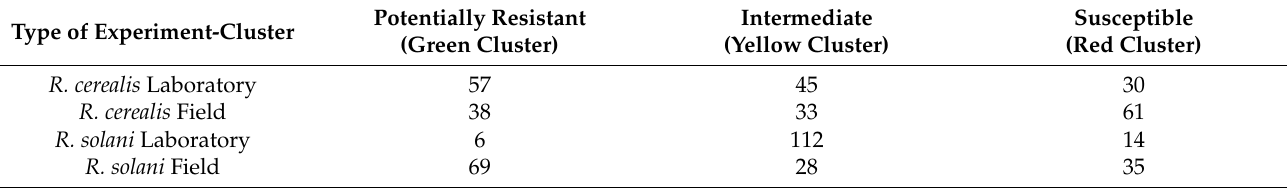
Table 2. Cluster cardinality of each experiment variant according to disease